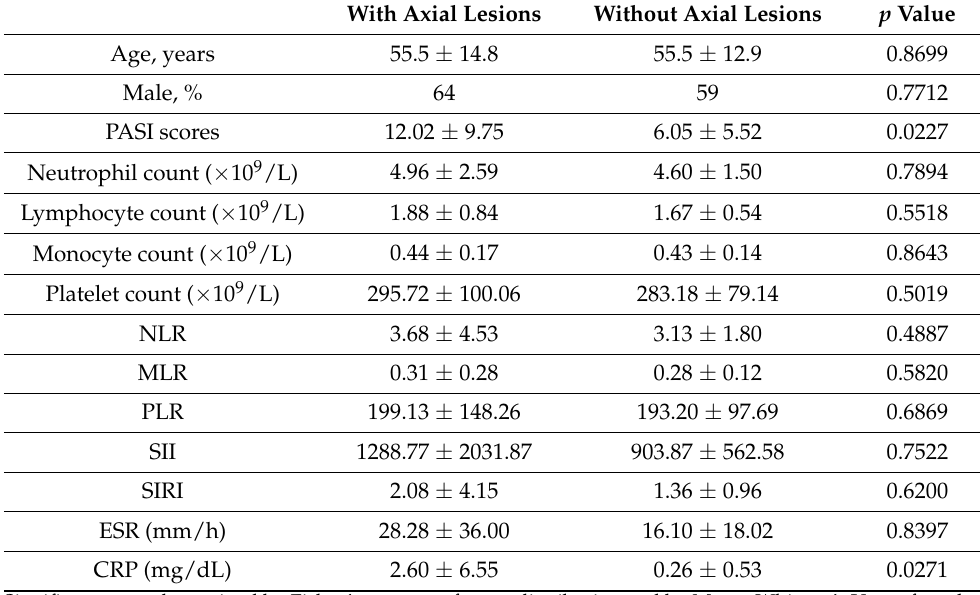
Table 4. Characteristics and systemic inflammatory markers among patients with psoriatic arthritis with or without axial